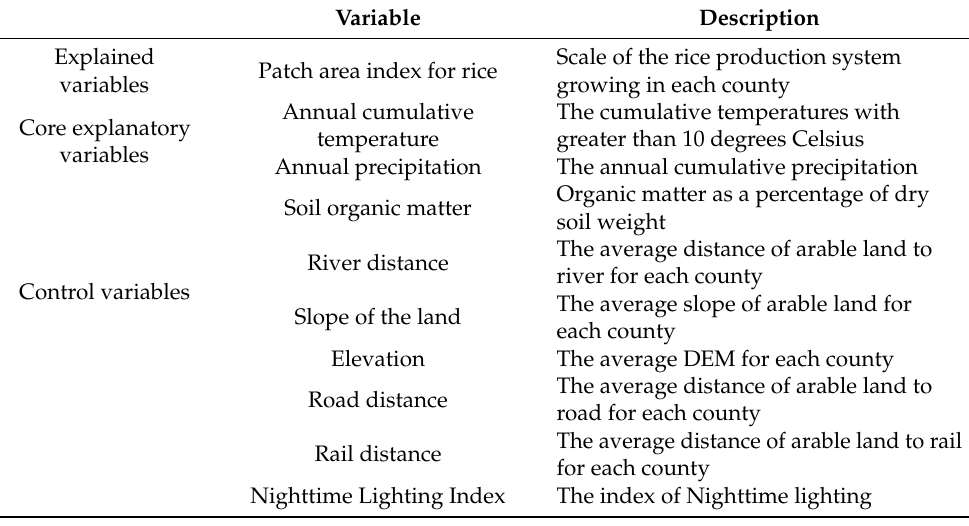
Table 1. Description of related